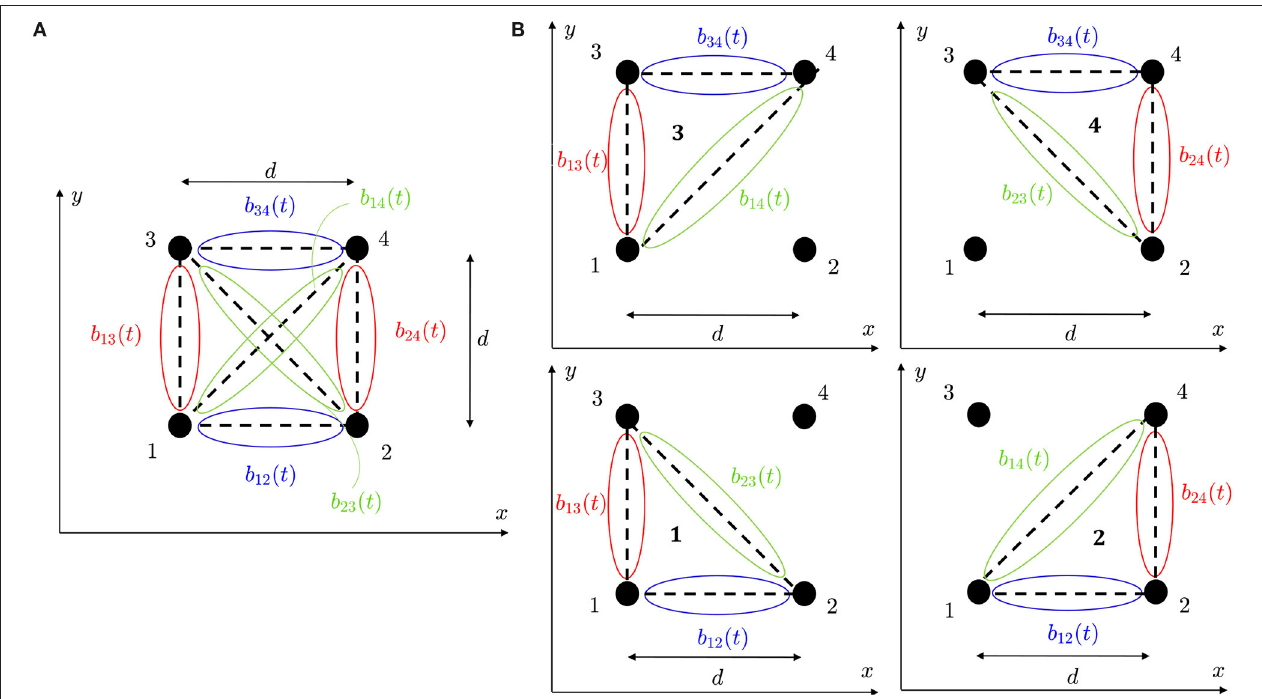
FIGURE 3 | (A) Four-electrode clique. (B) Three-electrode